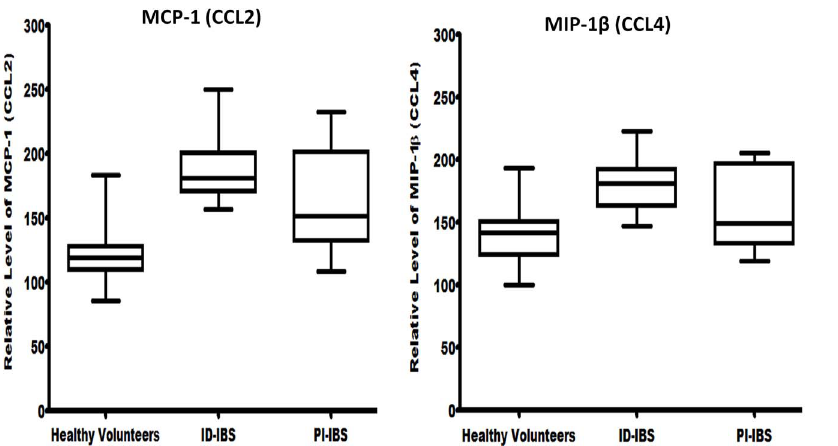
Figure 2. Sera from IBS patients show high levels of monocytes chemotactic protein-1 (MCP-1) and macrophage inflammatory protein-1 b (MIP-1 b ). Sera (250 m L) from IBS patients (44 idiopathic IBS, 16 post-infectious IBS, and 40 healthy volunteers) were analyzed for the presence of 36 biomarkers using the Proteome Profiler Human Cytokine Array Panel A kit (R&D Systems, Minneapolis, MN). Following chemiluminescent detection and processing, the intensities of the blots were determined using ImageJ (National Institutes of Health, Bethesda, MD) and expressed as pixel density. Logistic regression analysis indicated that the amounts of MCP-1 and MIP-1 b in the sera were significantly higher in both ID-IBS and PI-IBS (p-values 0.003 and 0.010, respectively) when compared to that of the healthy volunteers. The odds ratios of association between IBS and overexpression of MCP-1 and MIP-1 b were 1.054 (95% CI: 1.011–1.100), 1.021 (95% CI: 1.048–1.061), respectively.